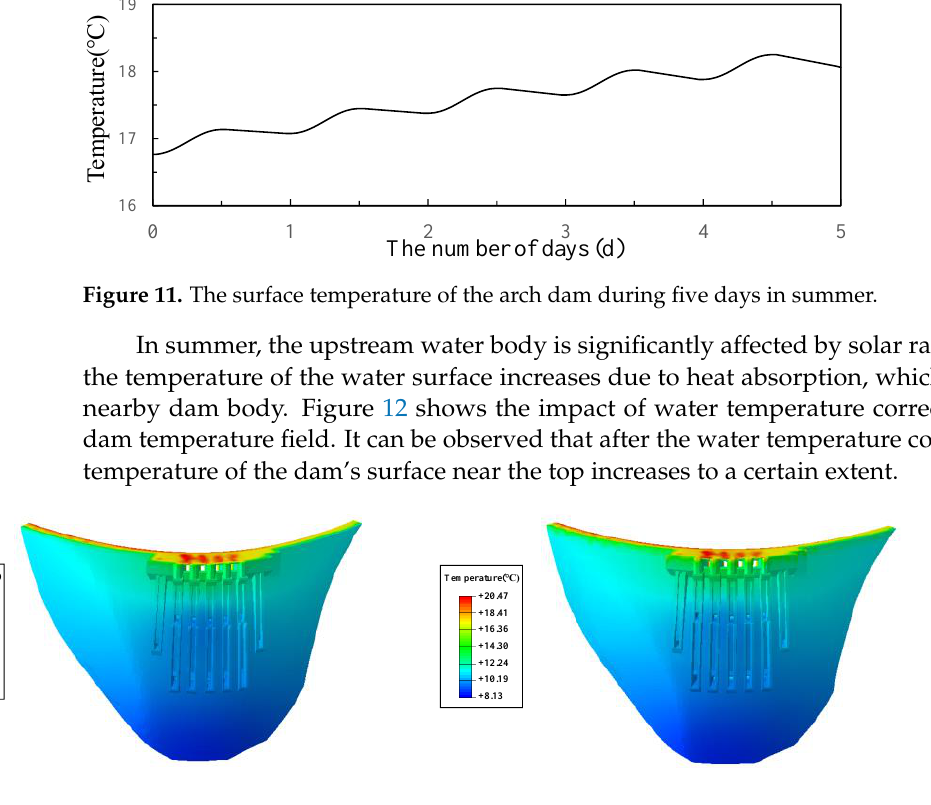
Figure 12. The impact of summer water temperature correction on the temperature field of the arch dam. ( a ) Without consideration of solar radiation. ( b ) Consideration of solar radiation. The dam temperature increased by 2 to 5 °C and the dam deformed by 0.42 mm to- deformation center was biased towards the left bank due to the strong solar radiation on the left bank. The deformation caused by solar radiation of a whole day was relatively small, but under the influence of continuous clear weather, the maximum deformation caused by solar radiation was 3.87 mm towards the upstream part of the dam, as shown in Figure 14.